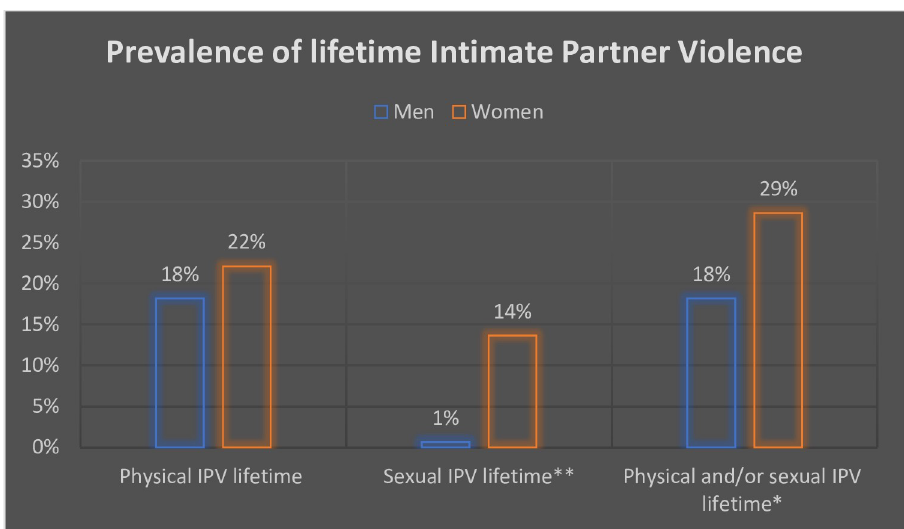
Fig 1. Prevalence of men’s perpetration and women’s experiences of different forms of Intimate Partner Violence in their